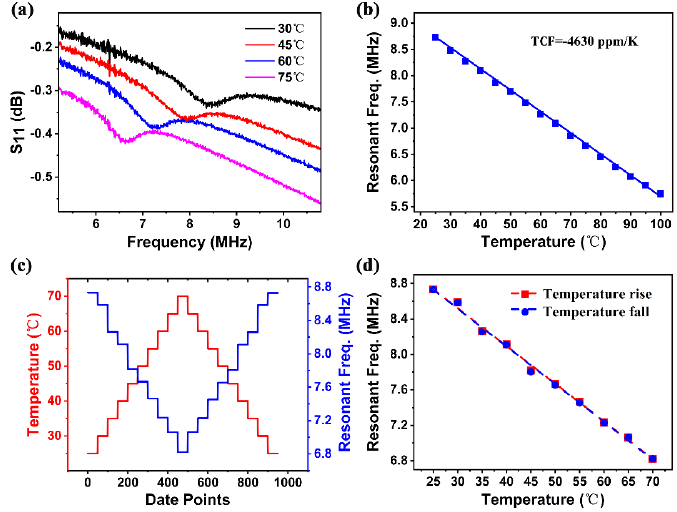
Figure 7. ( a ) Reflection spectra of device under different temperatures; ( b ) resonant frequency as function of temperature, showing temperature coefficient of −4630 ppm/K frequency, calculated from gradient; ( c ) frequency at each temperature test point for 50 times; ( d ) frequency shift under cyclic temperature scanning, showing good consistency with no visible hysteresis.